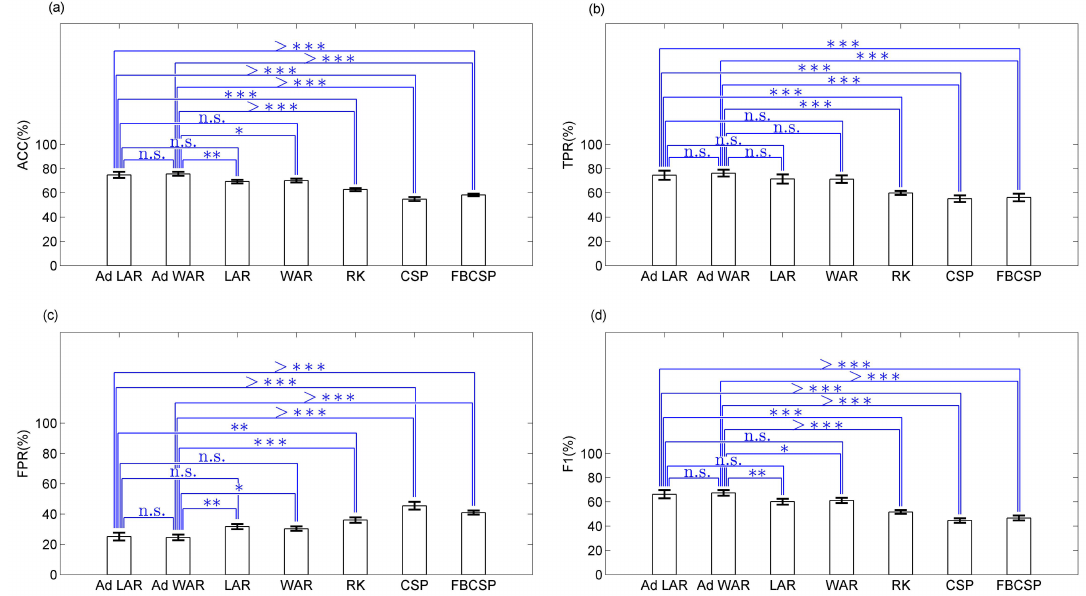
Figure 6. Performance of the BCI during the gait planning recognition, applying Ad LAR, Ad WAR, LAR, WAR, RK, CSP and FBCSP filters. p values representation ( n . s non-significant, p > 0.05; ∗ p < 0.05; ∗∗ p < 0.01; ∗∗∗ p < 0.001; > ∗∗∗ p < 0.0001). ( a ) accuracy; ( b ) true positive rate; ( c ) false positive rate; ( d ) F1